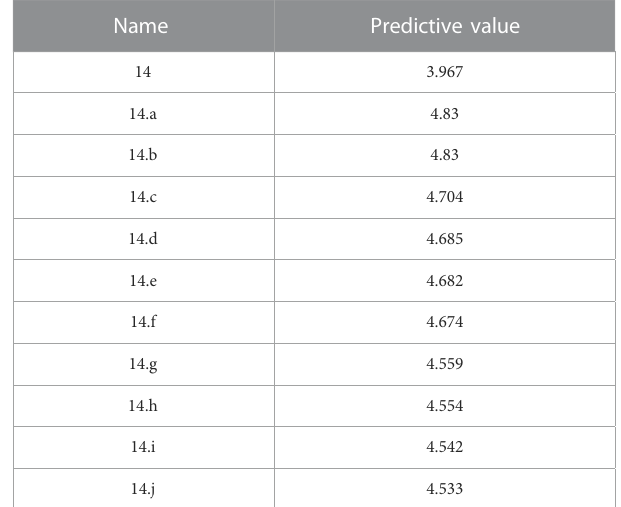
TABLE 6 New compounds designed and their predicted